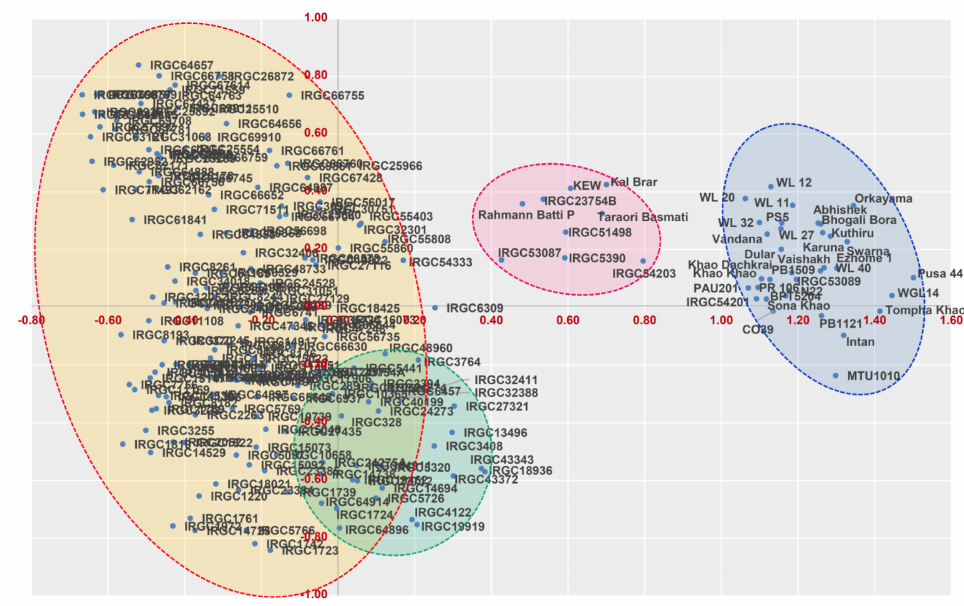
Figure 3. Principal coordinate analysis of 200 tropical japonica lines and 36 check lines based on 46 SSR